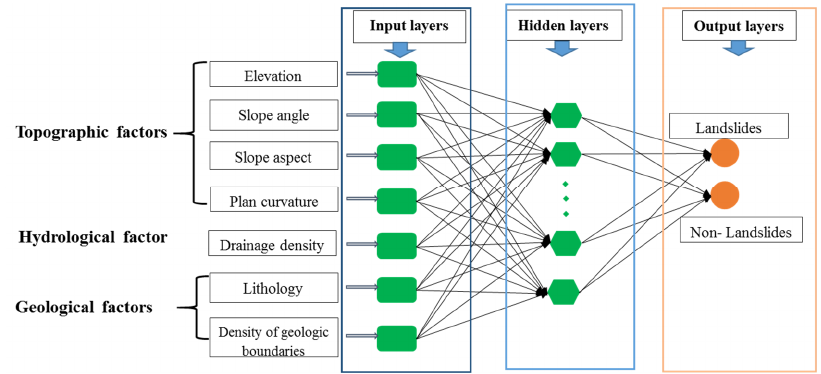
Figure 6. Structure of a three-layer of neural networks for landslide susceptibility analysis. Table 3. The setting variables in the artificial neural network (ANN) model. Variables Setting Initial weights 0.1–0.25 Root mean square error (RMSE) 0.001 Momentum parameters 0.9